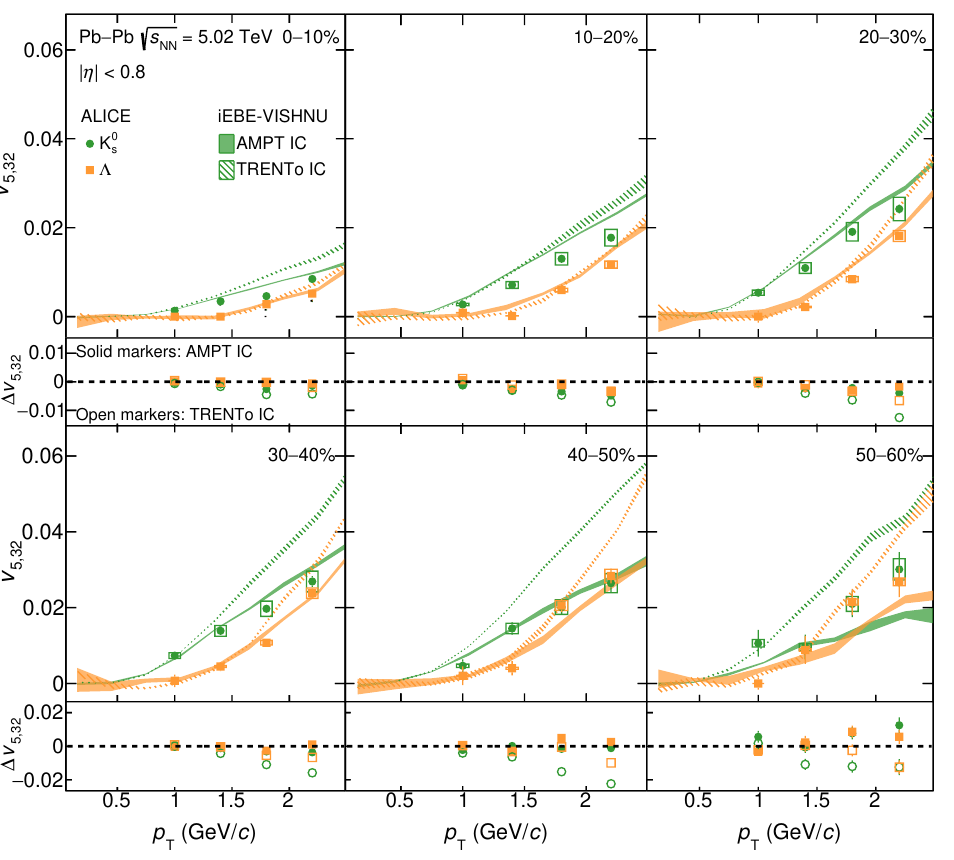
Figure 20 . The p T -di(cid:11)erential v 5 ; 32 of K 0 and (cid:3) + (cid:3) in the 0{10% up to 50{60% centrality S p intervals of Pb-Pb collisions at s NN = 5 : 02 TeVcompared with iEBE-VISHNU hybrid models with two di(cid:11)erent sets of initial parameters: AMPT initial conditions ( (cid:17)=s = 0.08 and (cid:16)=s = 0) shown as solid bands and TRENTo initial conditions ( (cid:17)=s (T) and (cid:16)=s (T)) as hatched bands. The bottom panels show the di(cid:11)erence between the measurements and each model. Statistical and systematic uncertainties are shown as bars and boxes,